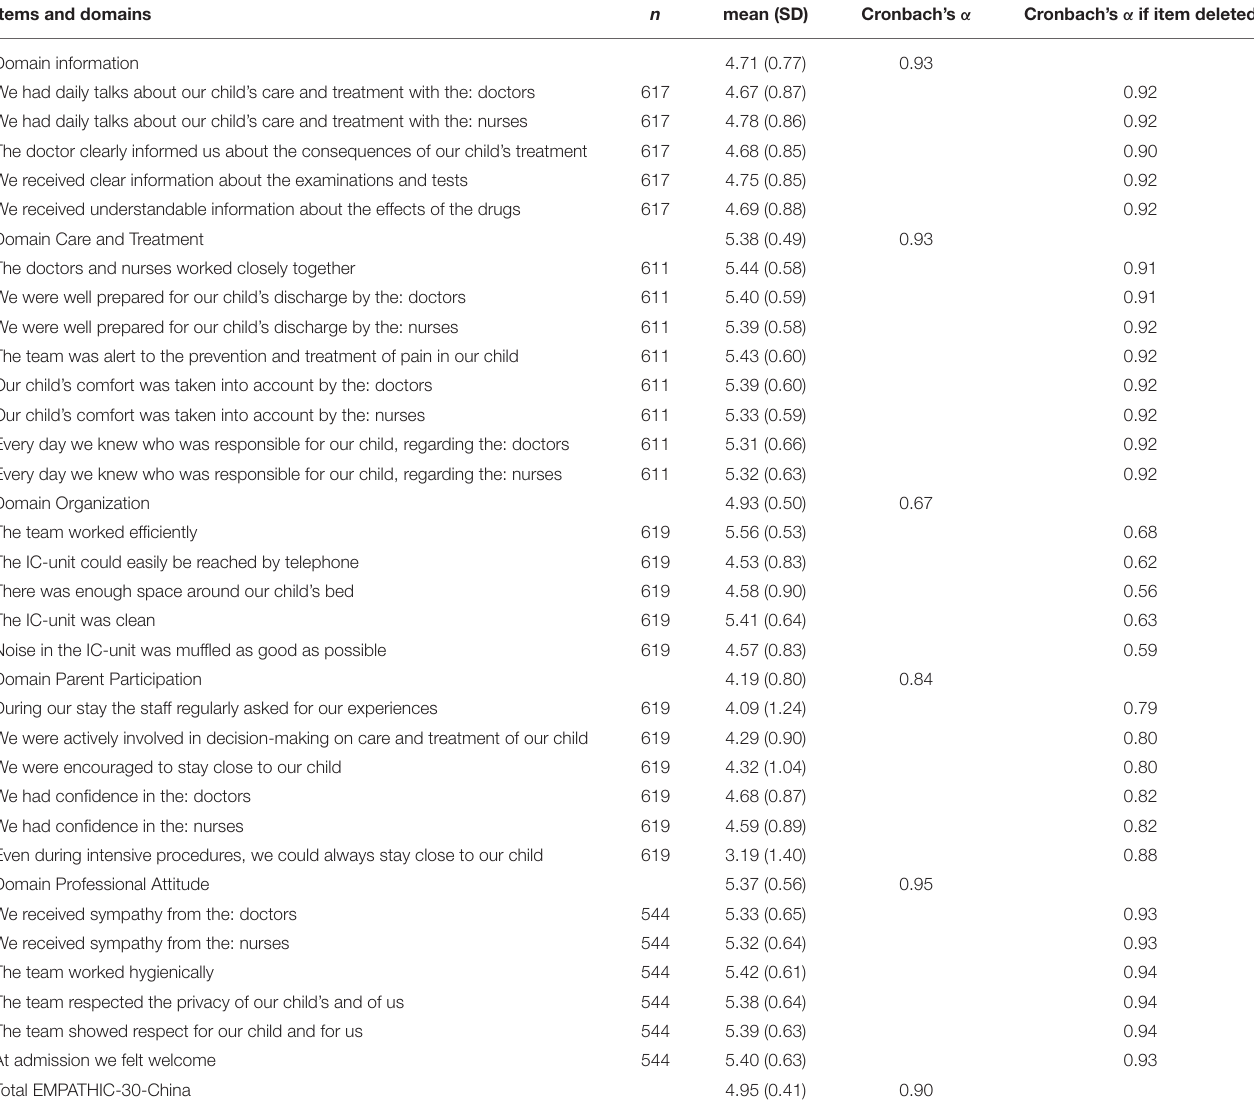
TABLE 2 | Descriptive statistics and Cronbach’s alpha of items and domains. Items and